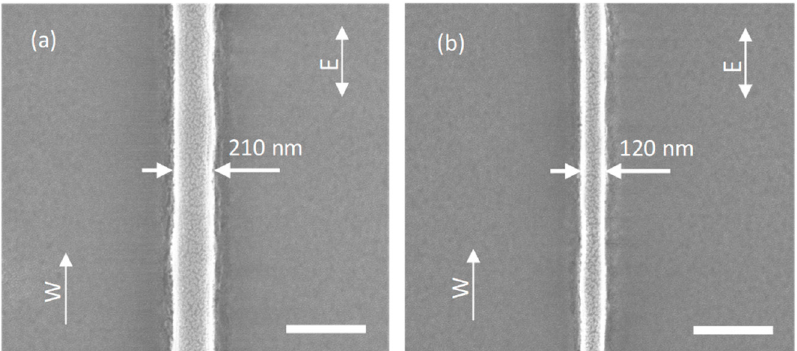
Figure 4. Scanning electron micrograph of one-beam direct laser writing nanowires, ( a ) 15 mW excitation power, ( b ) 11 mW excitation power. W: scanning direction, E: laser polarization direction, scale bar 400 nm.